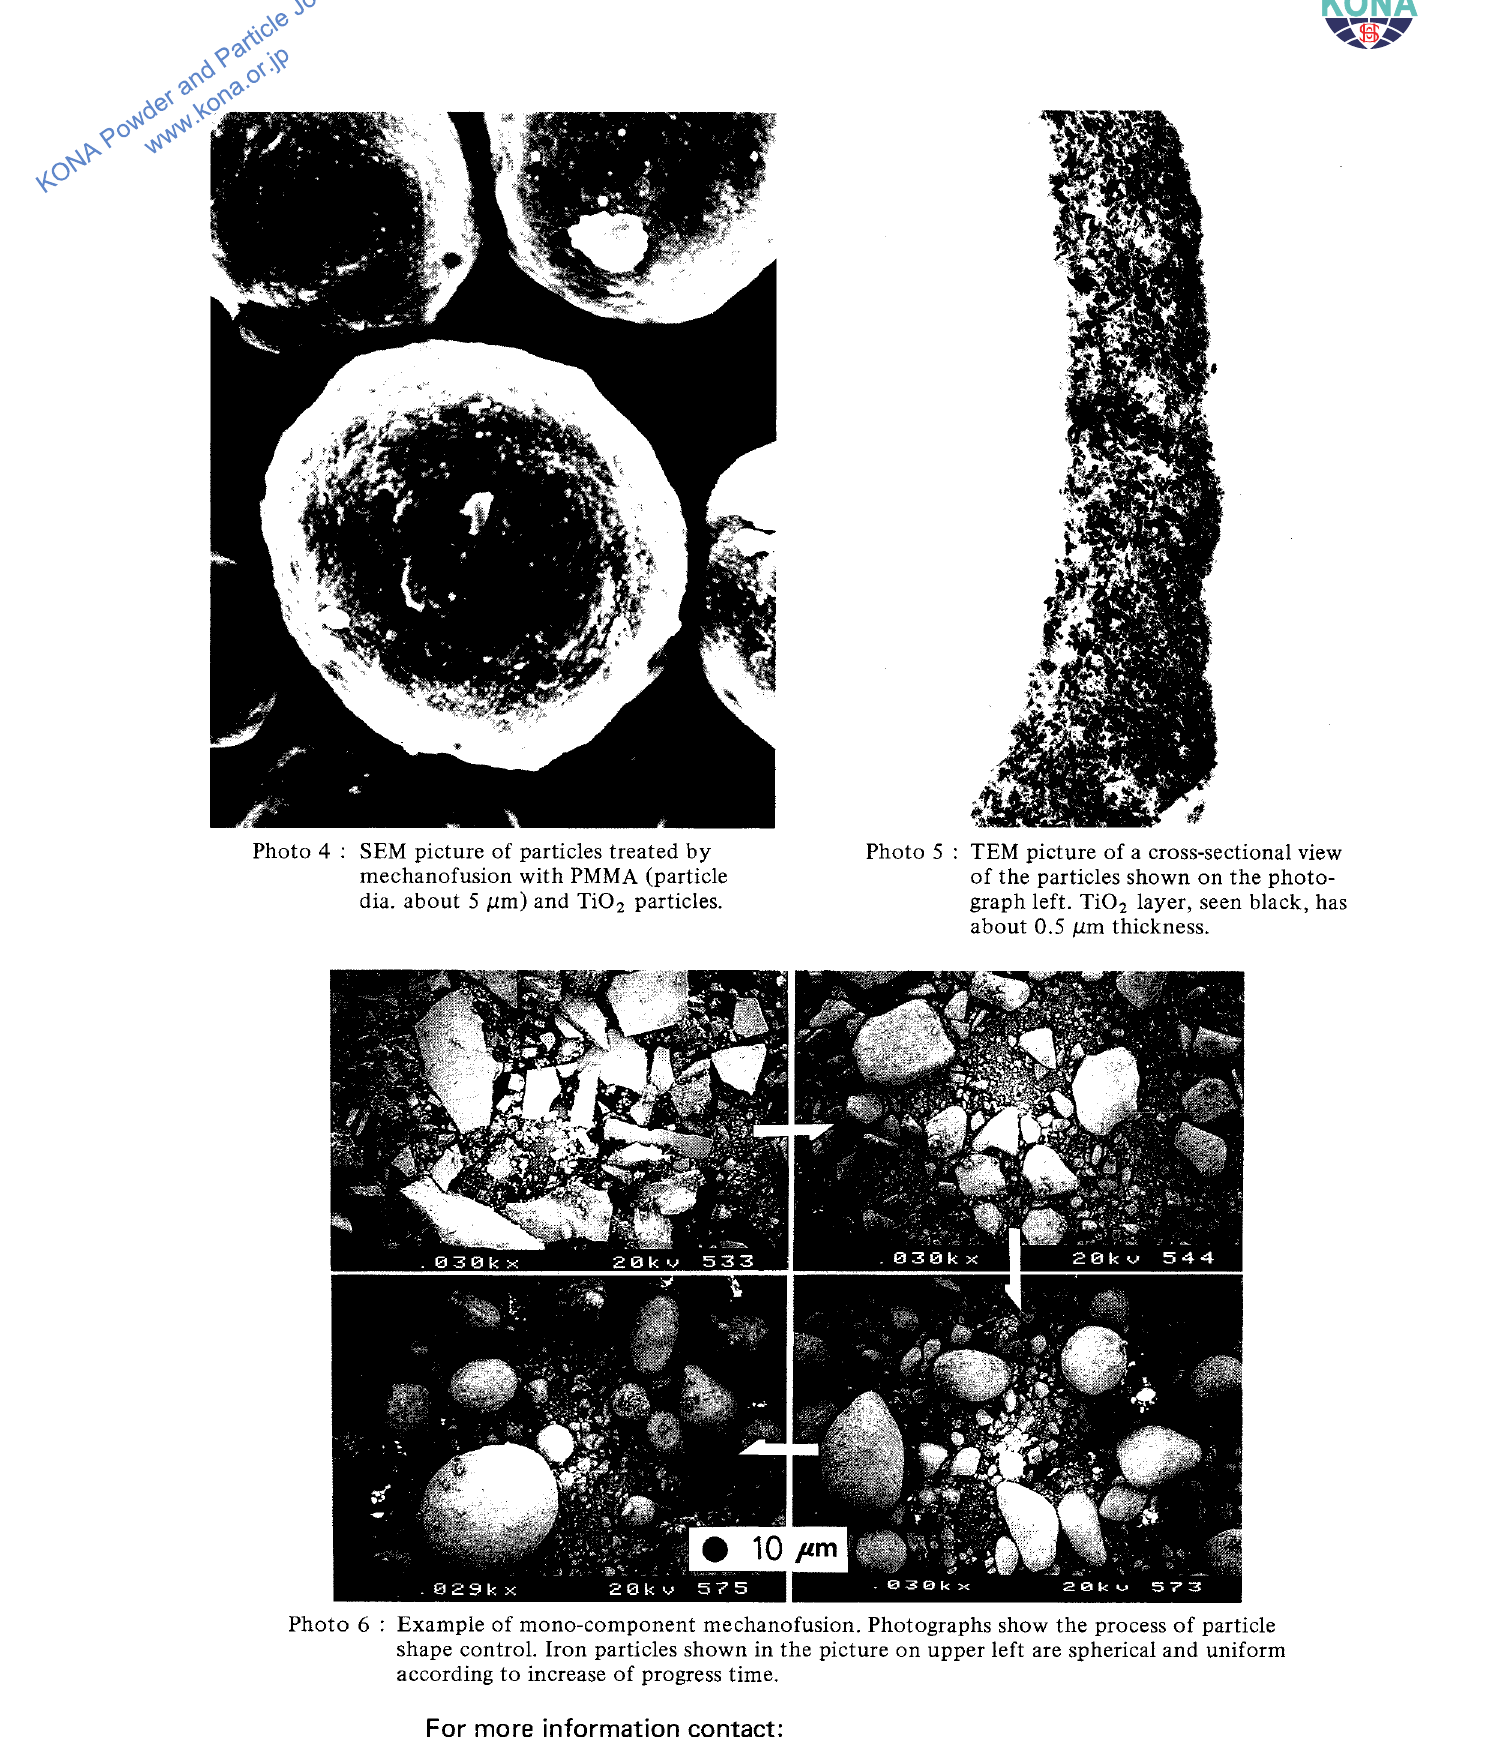
Photo 6 : Example of mono-component mechanofusion. Photographs show the process of particle shape control. Iron particles shown in the picture on upper left are spherical and uniform according to increase of progress